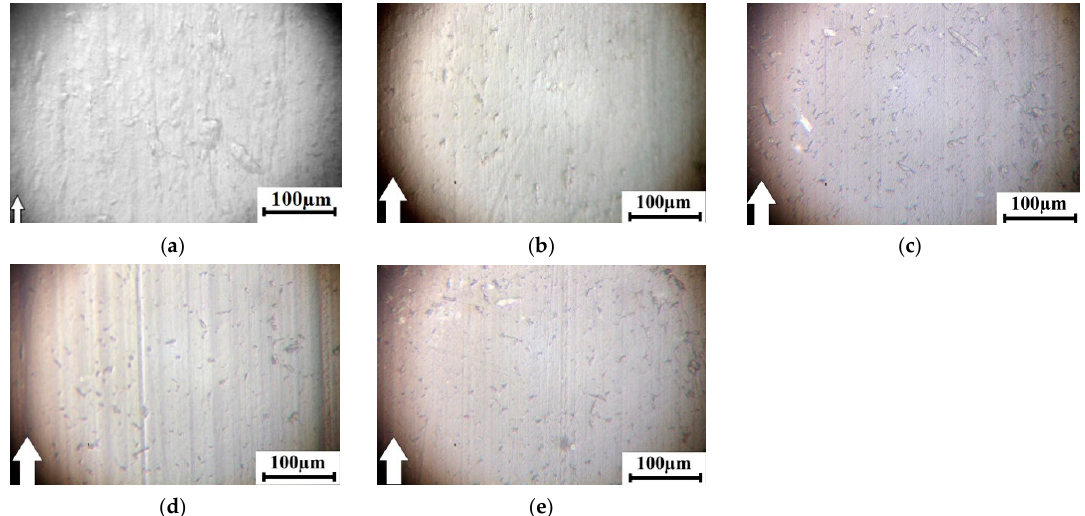
Figure 8. Optical images of the wear track surfaces of neat UHMWPE ( a ); and the “UHMWPE + 7 wt. % wollastonite” composites: untreated ( b ); “KH-550” ( c ); “Penta-1006” ( d ); and “OTS” ( e ) (Load = 60 N, Velocity = 0.3 m ∙ s − 1 ). Appl. Sci. 2020 , 10 , 4511